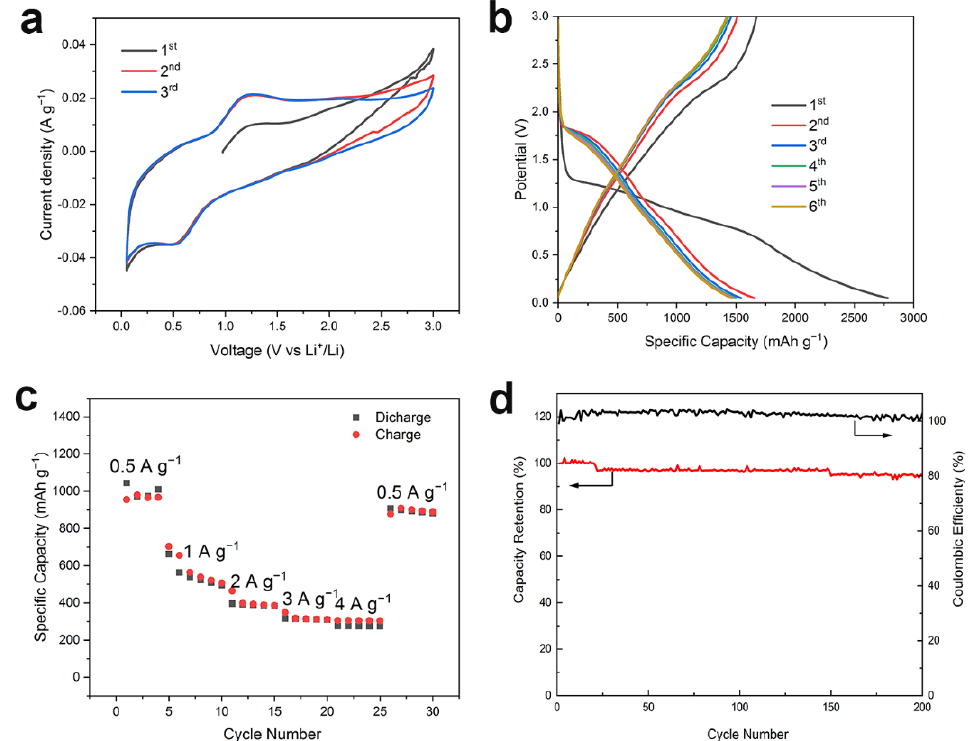
Figure 5. Electrochemical performance of the NiO-rGO. ( a ) CV curves at 0.1 mV s − 1 . ( b ) First four charge–discharge curves at 0.1 A g − 1 . ( c ) Rate performance. ( d ) Cyclic behavior at 0.5 A g − 1 .